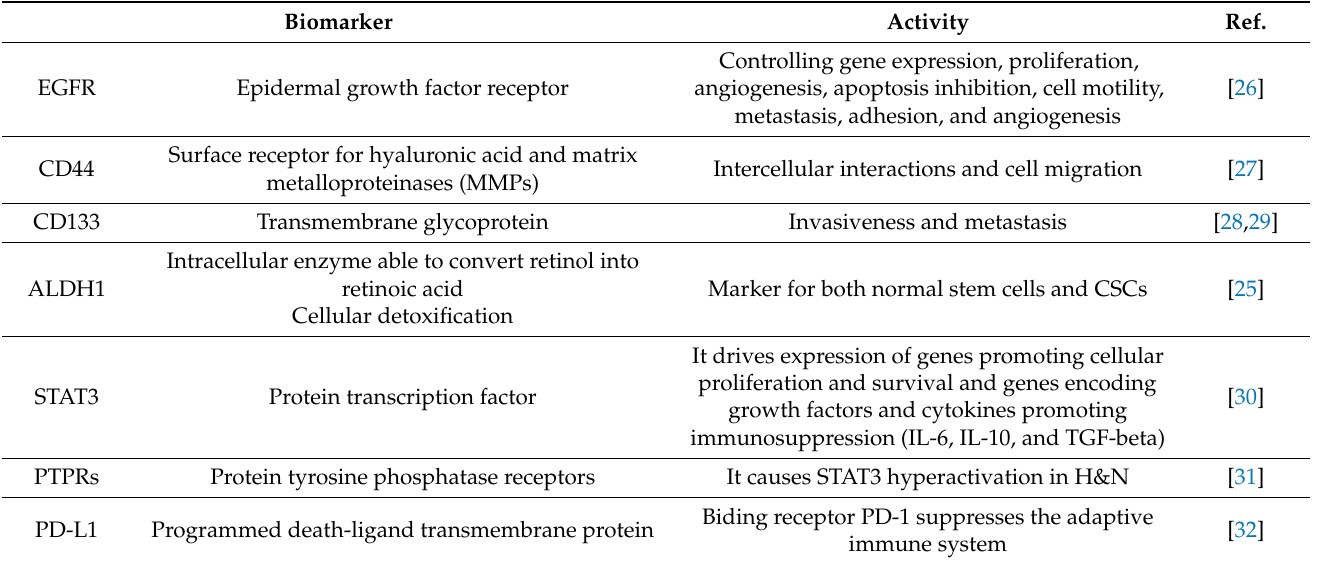
Table 1. Molecular biomarkers for HNSCC and